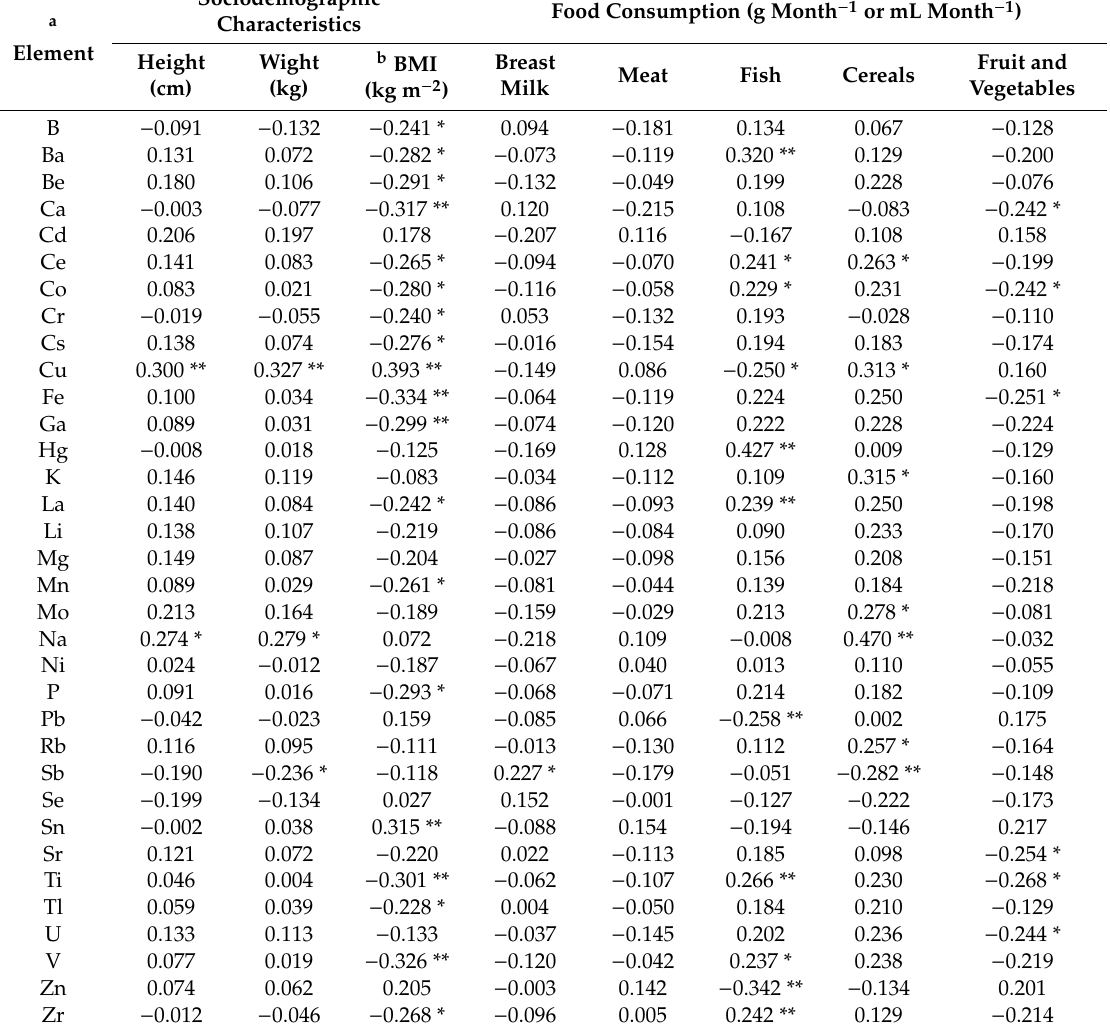
Table 5. Correlations between the levels of the elements in the hair and the characteristics of